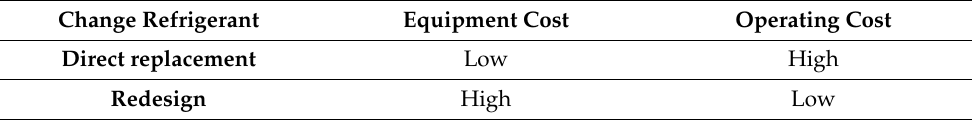
Table 1. Cost comparison of direct refrigerant replacement and compressor redesign.